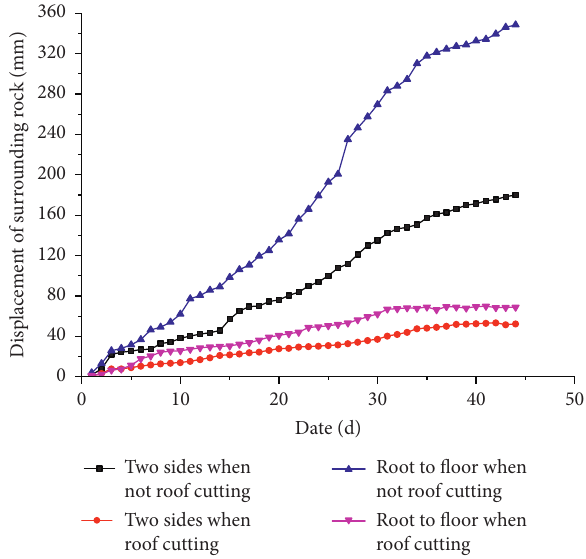
Figure 13: Deformation of the rock surrounding the main